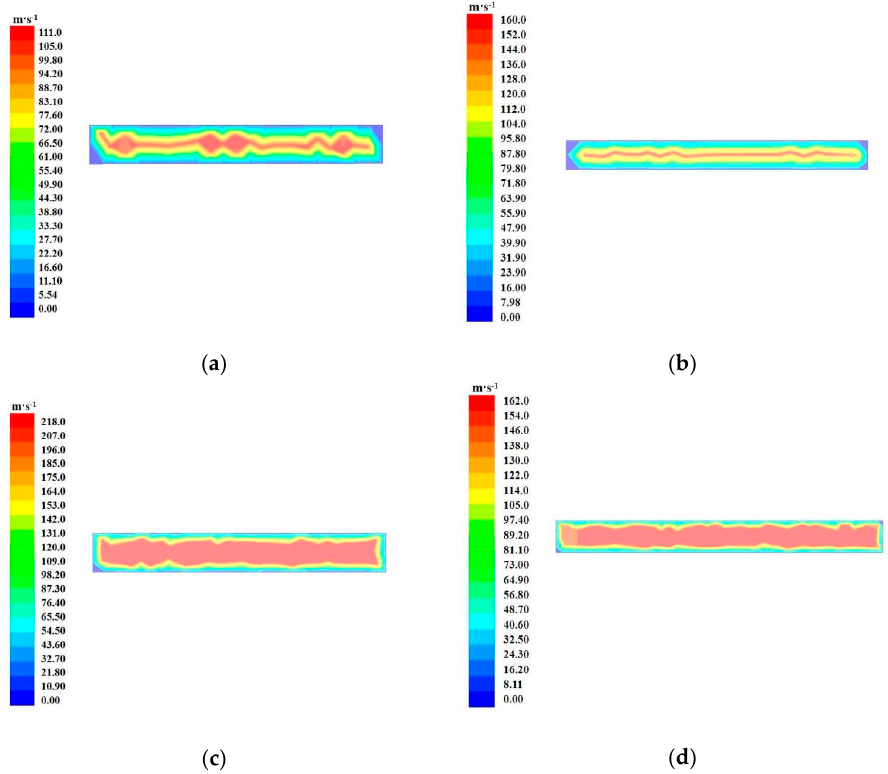
Figure 5. Velocity clouds of the outlet at different positions: ( a ) linear reduction outlet in the lower part; ( b ) Laval outlet in the lower part; ( c ) linear reduction outlet on the symmetric plane; ( d ) Laval outlet on the symmetric plane. In summary, the required range of flow velocities for the test could be achieved using a small centrifugal fan with an outlet on the symmetric plane. A uniform high-velocity flow can be achieved using a linear reduction outlet in cases of short outlet channels.